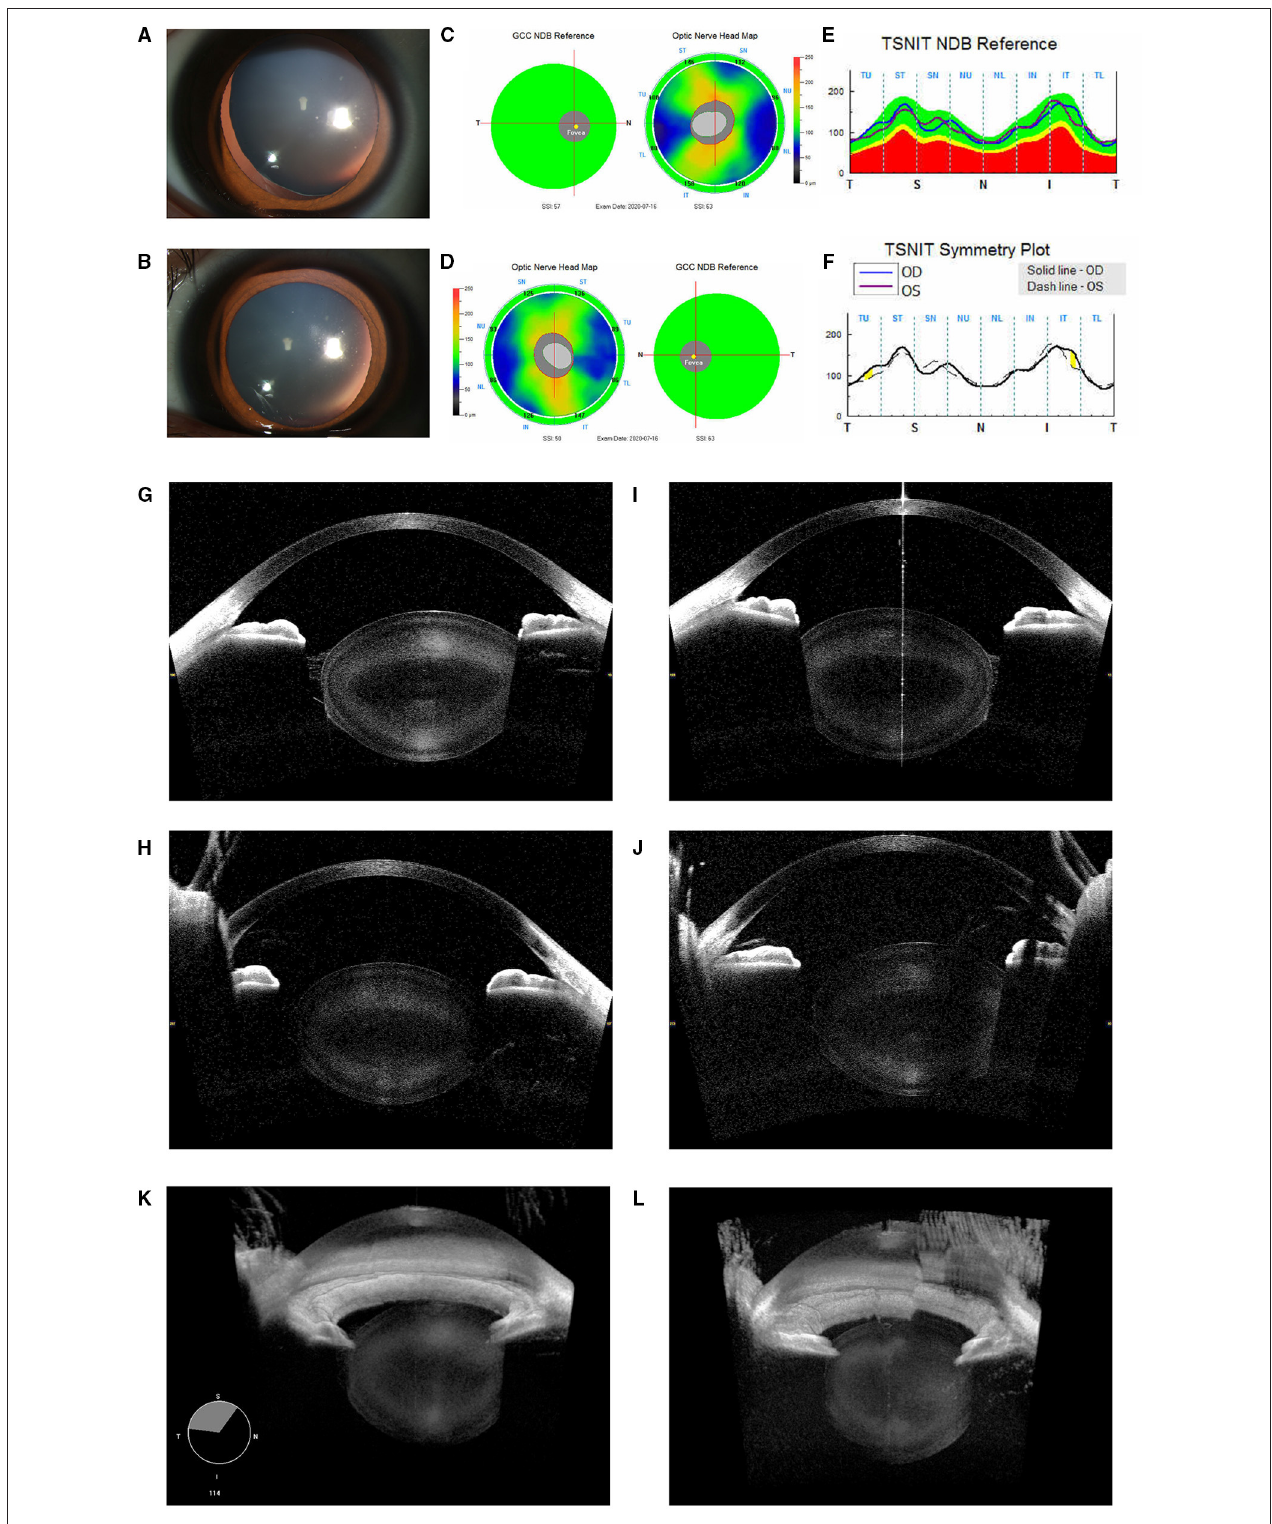
FIGURE 1 | Ocular images of Patient 1 with microspherophakia (MSP). (A) A slit-lamp photograph upon mydriasis showed the spherical lens with a mild dislocation in the right eye. (B) A slit-lamp photograph upon mydriasis showed the spherical lens with a minimal dislocation in the left eye. (C–F) RTVue optical coherence tomography (OCT) of the retinal neural fiber layer showed that no glaucomatous changes were observed in either eyes. (G) Horizontal section images of the right eye